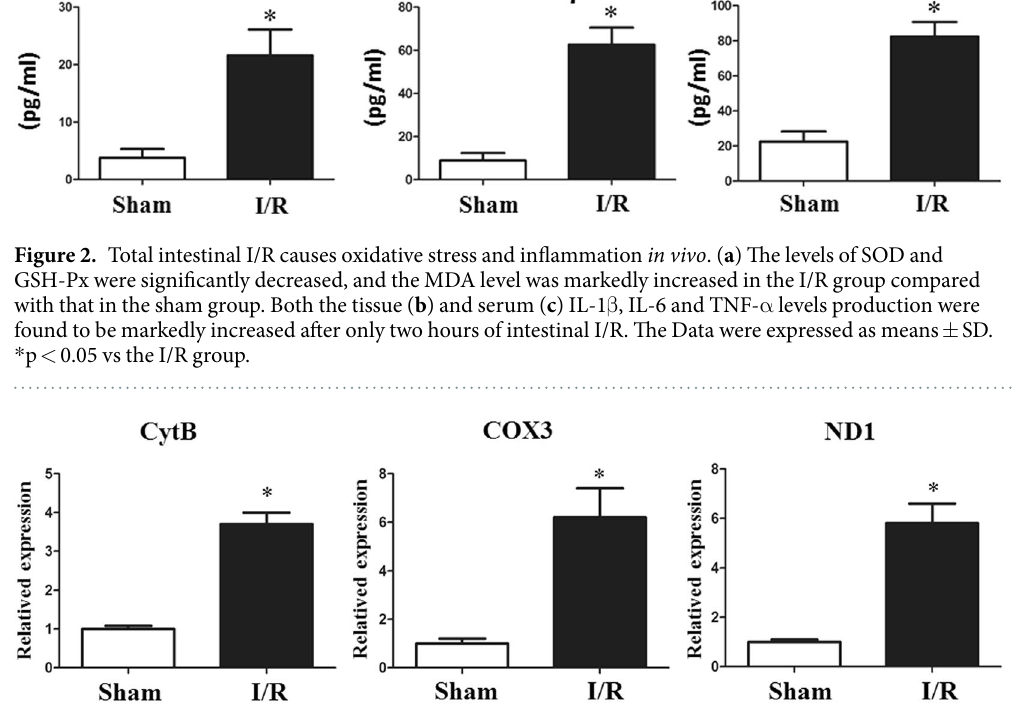
model, the I/R group displayed a significant increase in mtDNA compared with that in the control group (Fig. 3). Moreover, the increase in inflammatory cytokines was associated with an increase in circulatory mtDNA (data not shown).